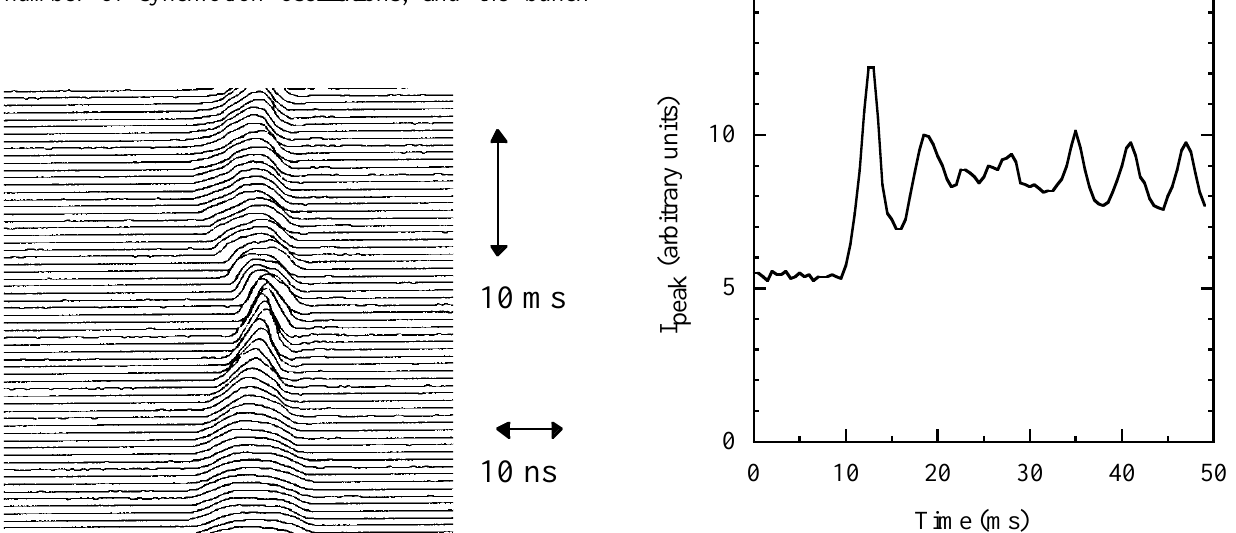
FIG. 6. Mountain range plot of the bunch after the transition energy was dropped to the beam energy.